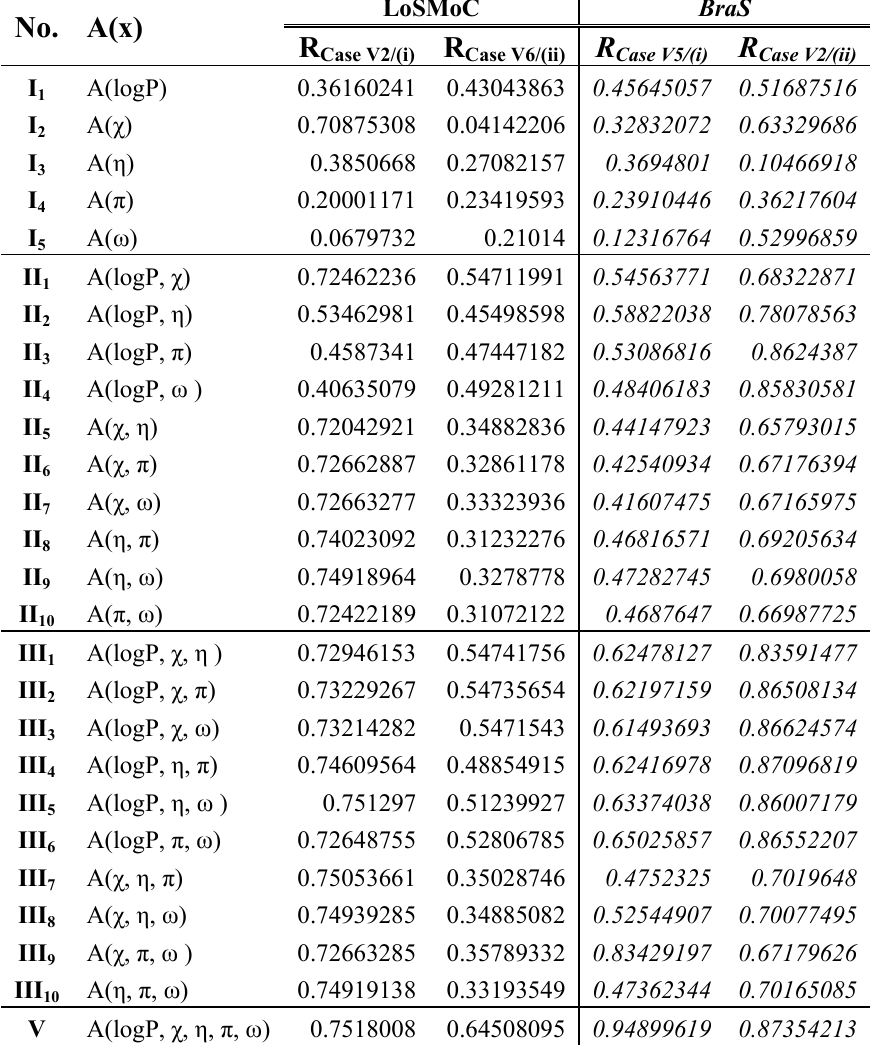
Table 4. Statistical correlation results obtained for cases V2/(i) and V6/(ii) for longest SMILES molecular chain (LoSMoC) and respectively for the cases V5/(i) and V2/(ii) for branching SMILES (BraS) selected compounds’ sets form Table 3 with respective molecules of Table 1 (detailed respective QSAR models dependencies on chemical reactivity parameters are provided in Supplementary Material—Table